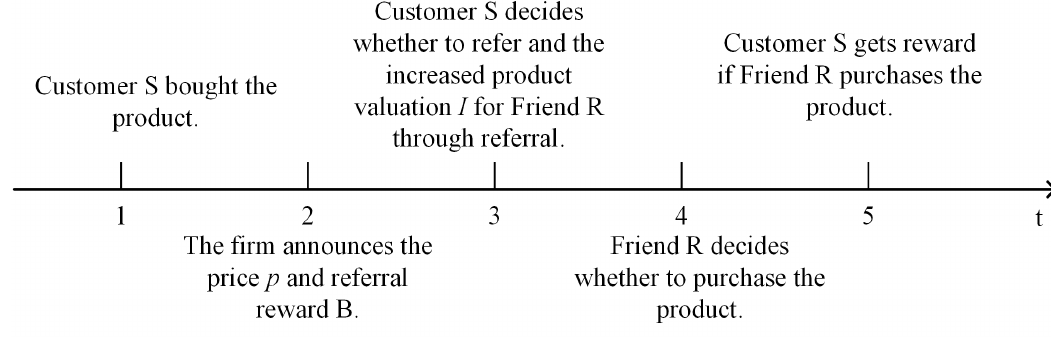
Figure 1. Sequence of